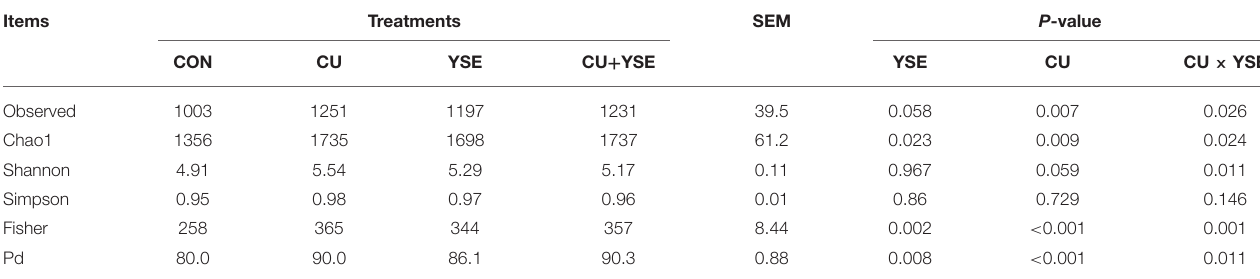
TABLE 10 | Alpha diversity analysis.